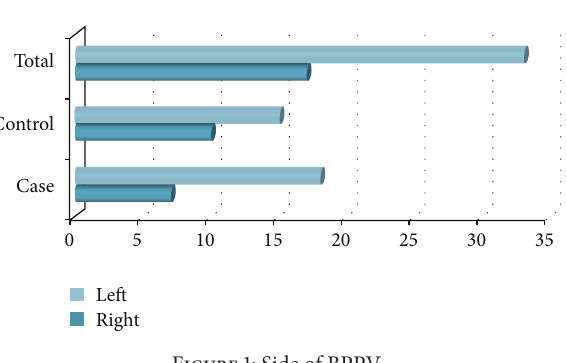
Figure 1: Side of